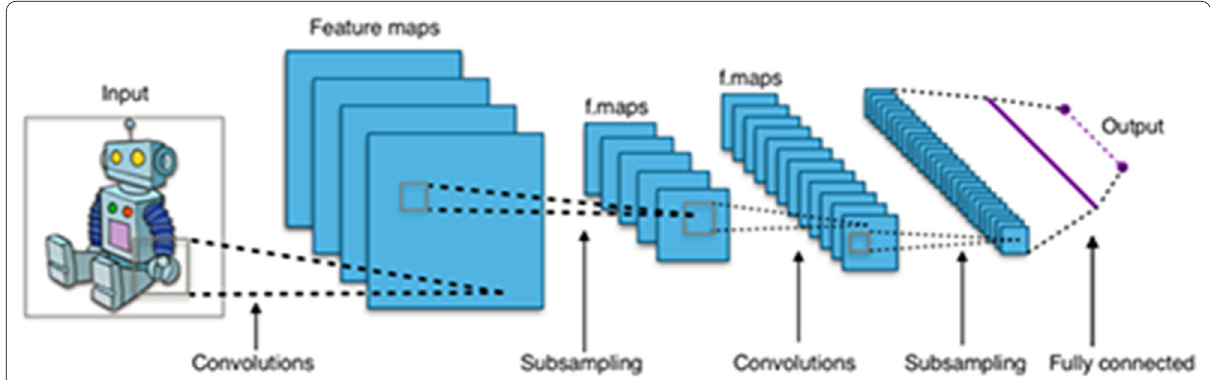
Fig. 12 General convolutional neural network